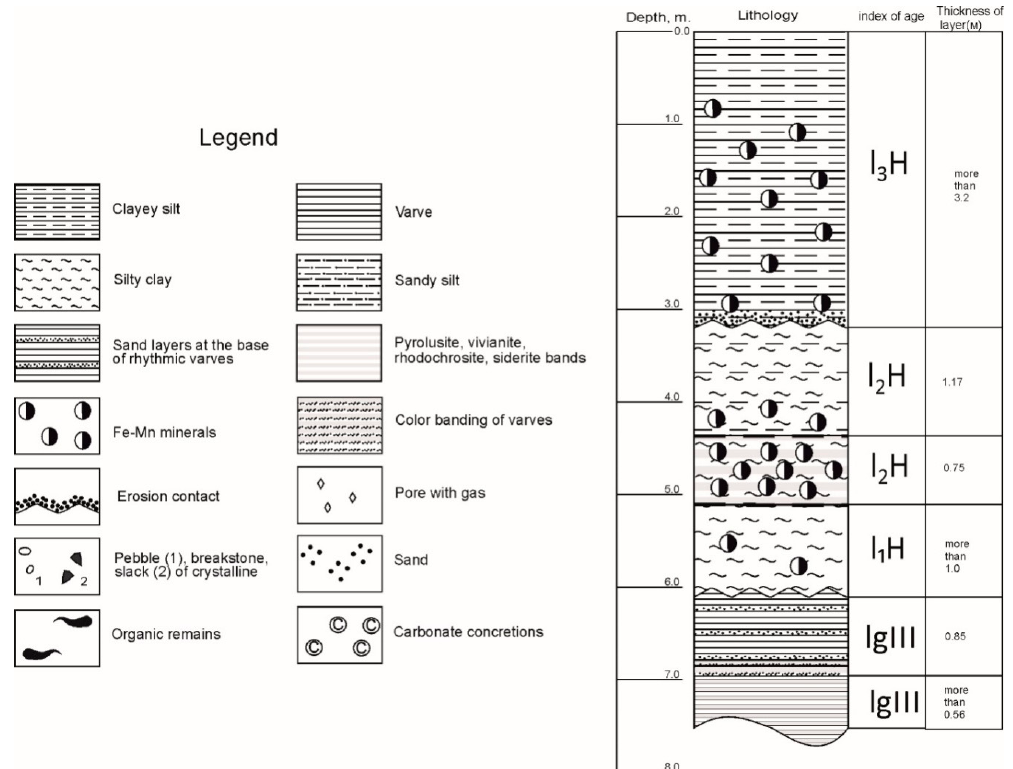
Figure 8. Lithostratigraphic section of Quaternary deposits in the Petrozavodsk Bay. Additionally, here we place legend for Figures 9, 10, and 12.